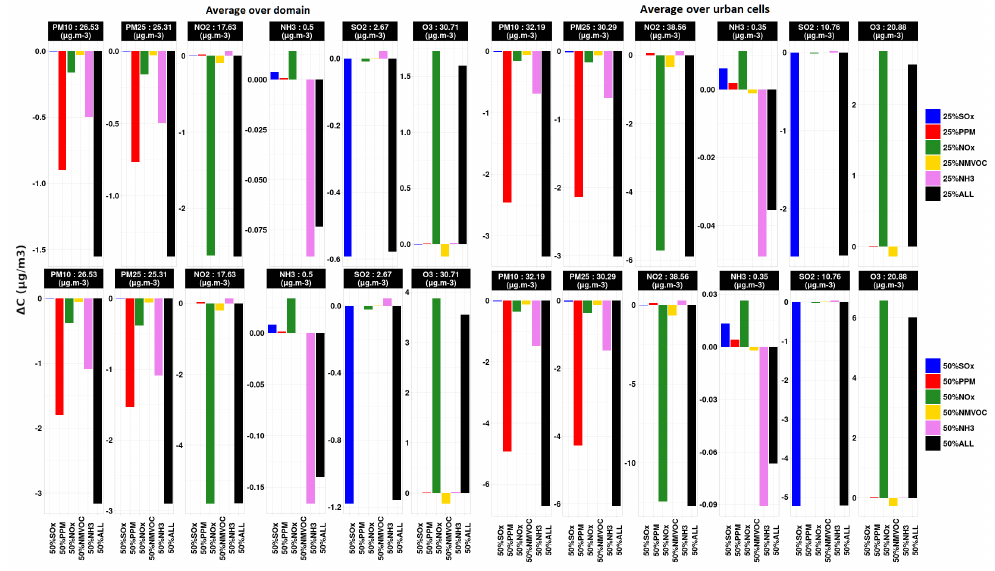
Figure 5. Delta between the reference simulation and each scenario. The 25% and 50% emission scenarios are presented in the top and bottom panels, respectively. The average value for the reference simulation is given above each panel. A legend for the scenarios and their correspondence is given on the right side of each panel. The deltas are averaged over the entire domain PAR03 on the left panels and over urban cells on the right